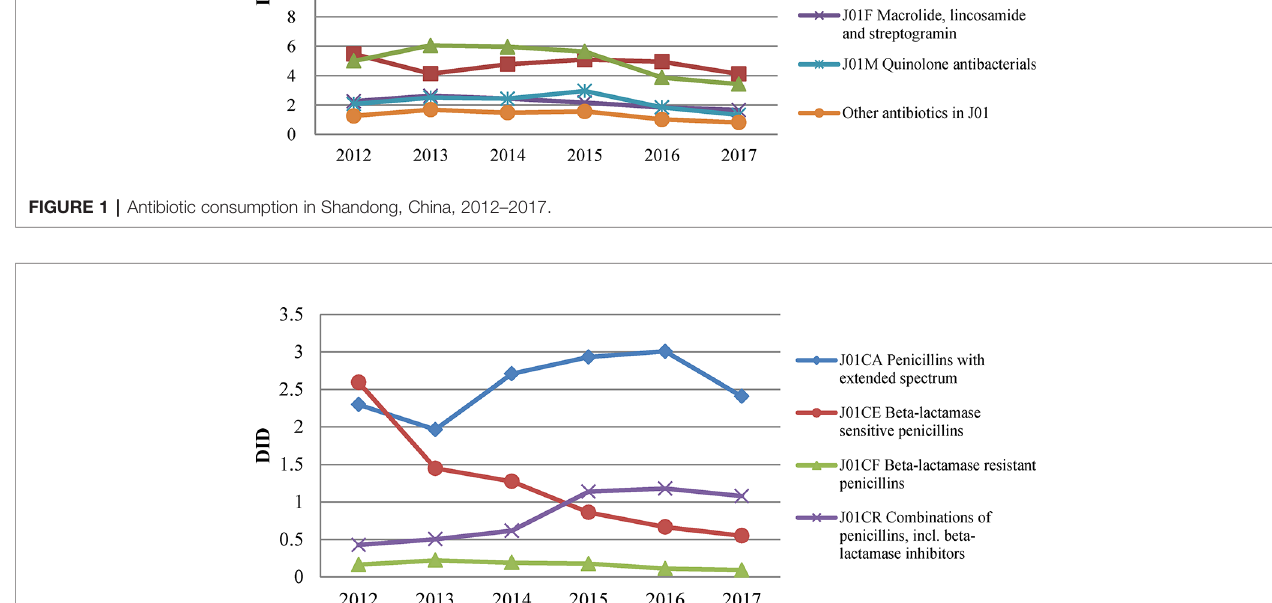
FIGURE 2 | Four types of penicillin consumed in Shandong, China, 2012 –